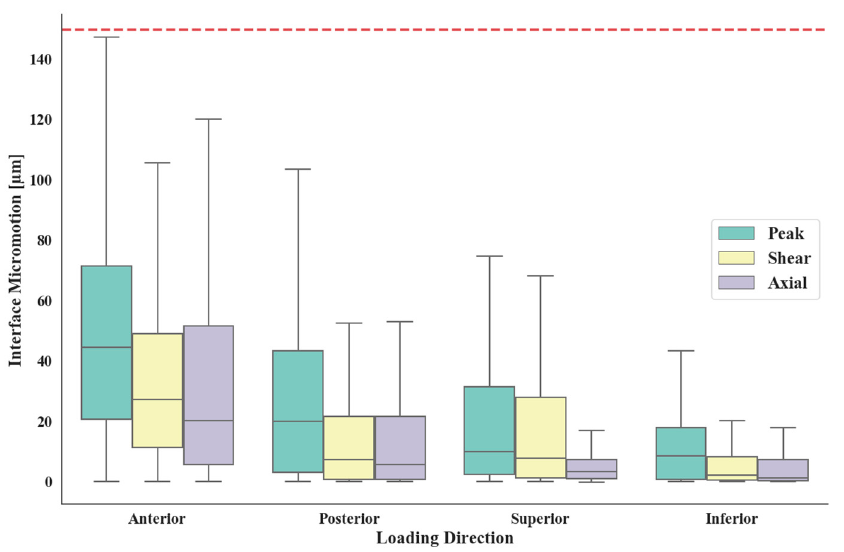
Figure 5. Interface micromotion. Shear and axial components of the total micromotion (peak) was evaluated for all the loading directions. The red dashed line represents the 150 µm threshold.